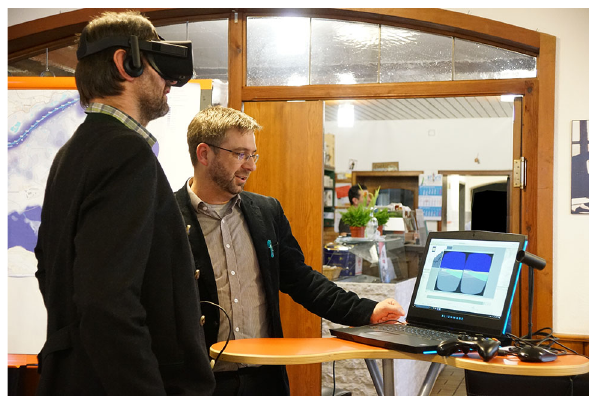
Fig. 4 Under the guidance of an expert, a participant walks via virtual reality through the groundwater model during exploratory phases of the 7 March 2017 round-table